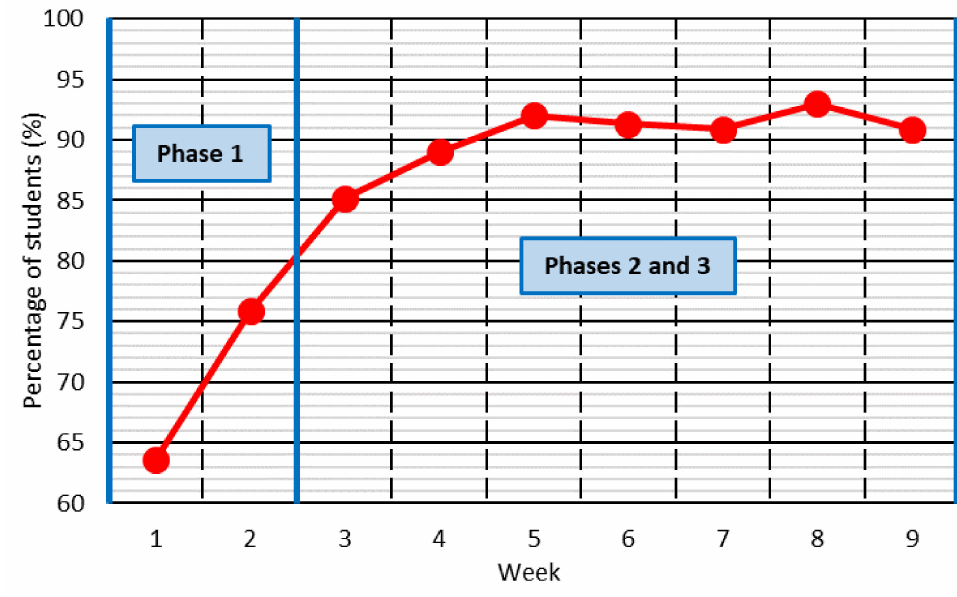
Figure 5. Percentage of students who considered successful adaptation to online